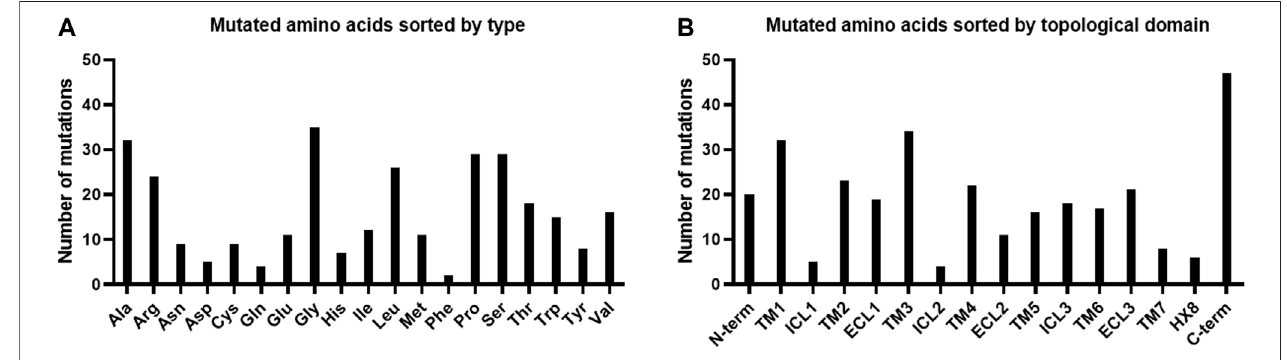
FIGURE 3 | Mutated amino acids affected by point mutations for G protein-coupled receptor 143 sorted by type (A) and sorted by topological domain (B)